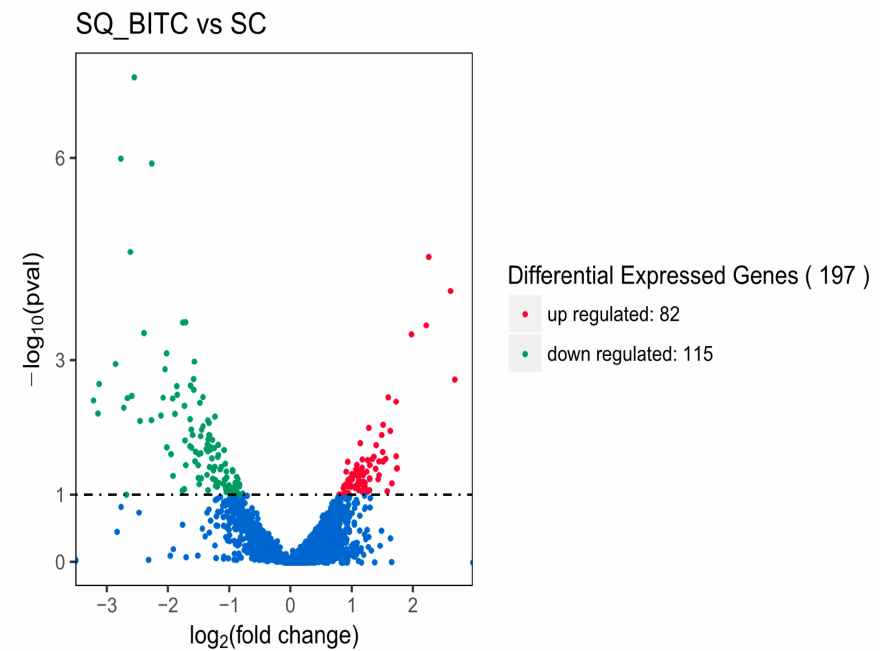
Figure 1. Volcano map of di ff erentially expressed genes (DEGs) for SQ_BITC vs SC. Di ff erent colors (red, green, and blue) represent upregulated, downregulated, and no significant changes, respectively, in DEGs between the SQ_BITC and SC